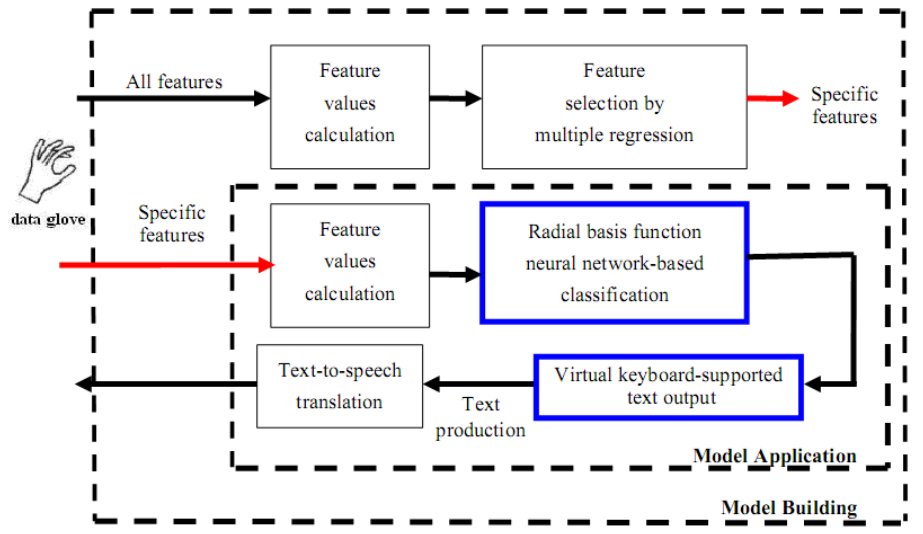
Figure 2. Techniques used in the